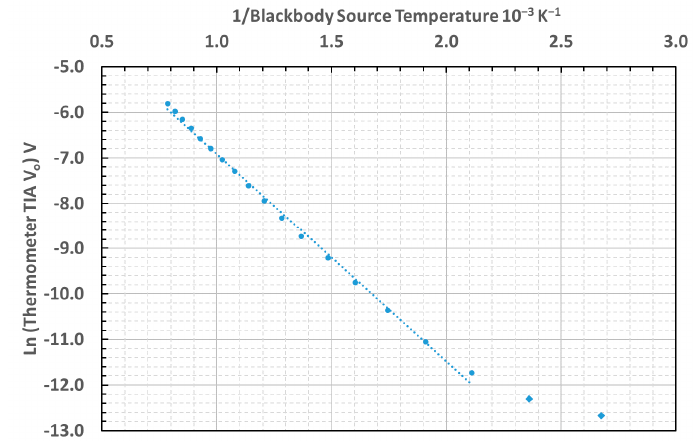
Figure 6. Characteristic inverse absolute temperature of blackbody versus Ln (TIA output voltage) curve for the thermometer.